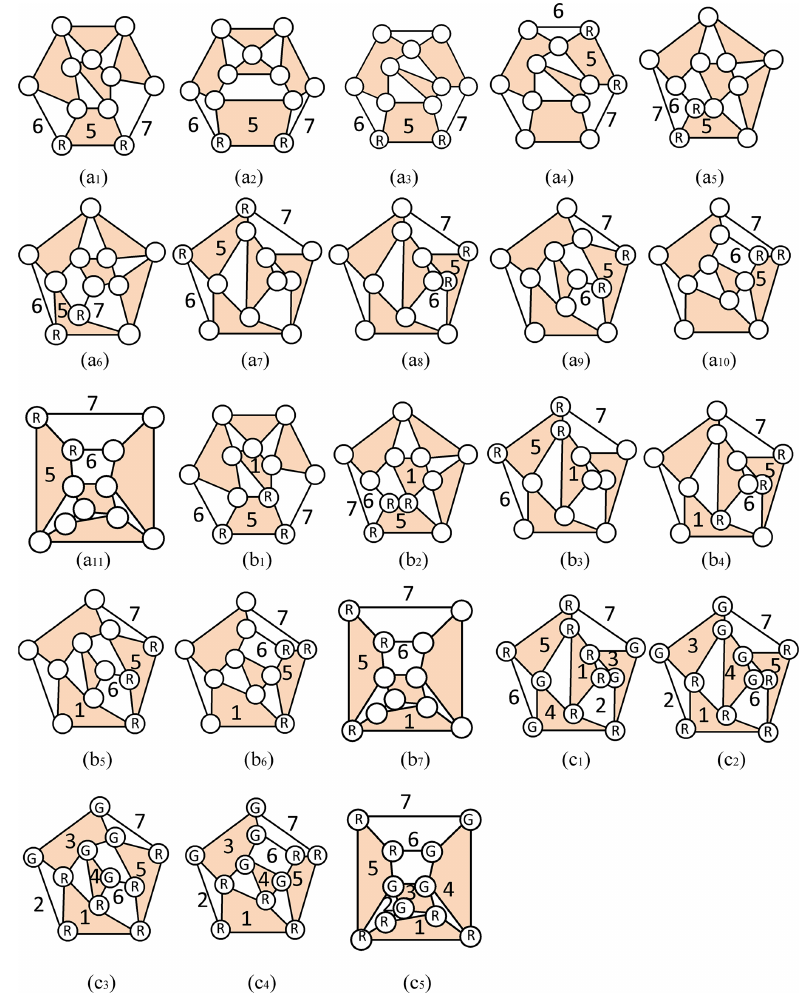
Figure 22. Specialized chains of the astronomical device.